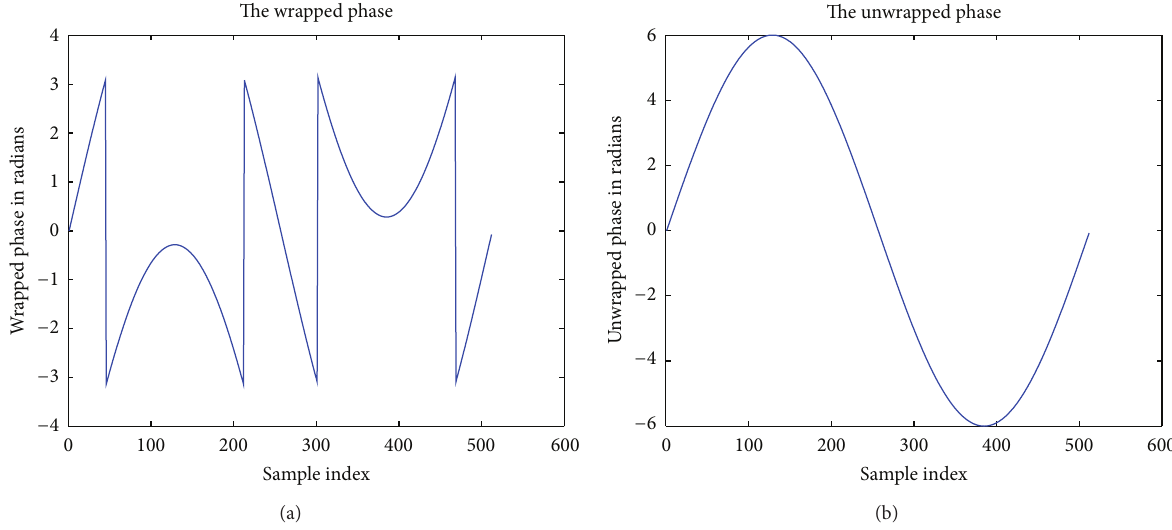
Figure 3: Phase unwrapping: (a) wrapped phase and (b) continuous phase.